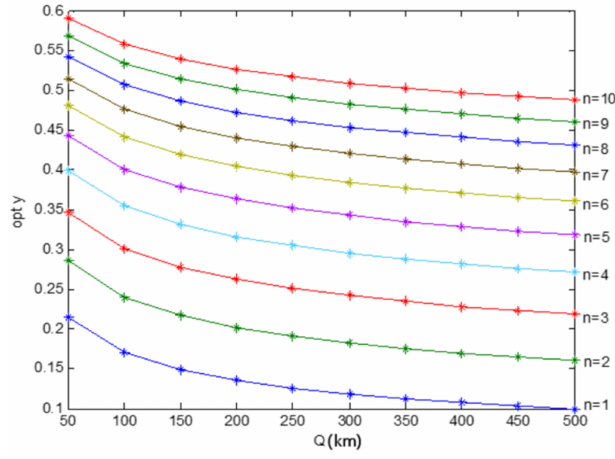
Figure 7. The optimal y under different driving range scenarios.